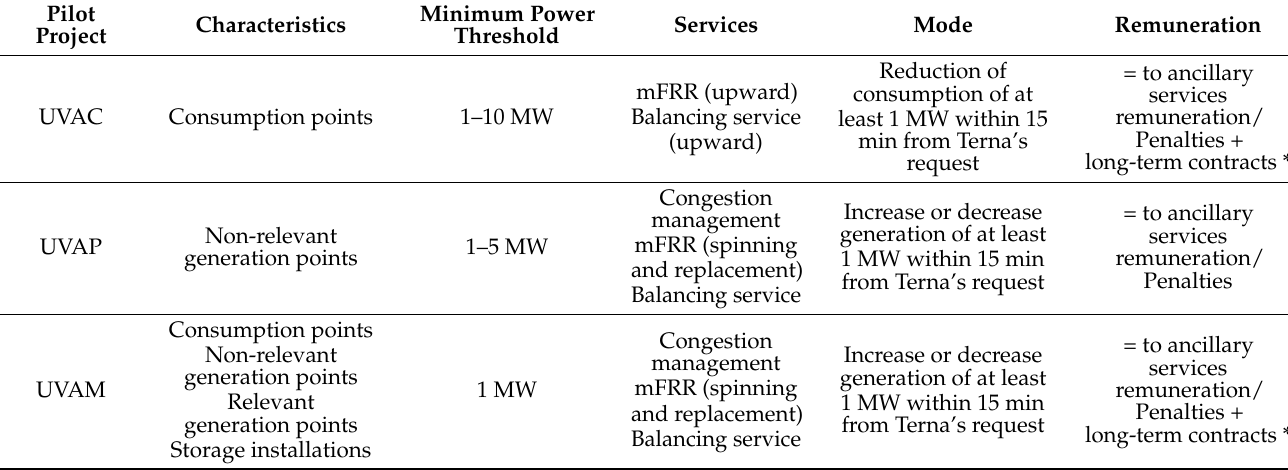
Table 3. Consumption virtual qualified units (UVAC), generation virtual qualified units (UVAP) and mixed virtual qualified units (UVAM) characteristics